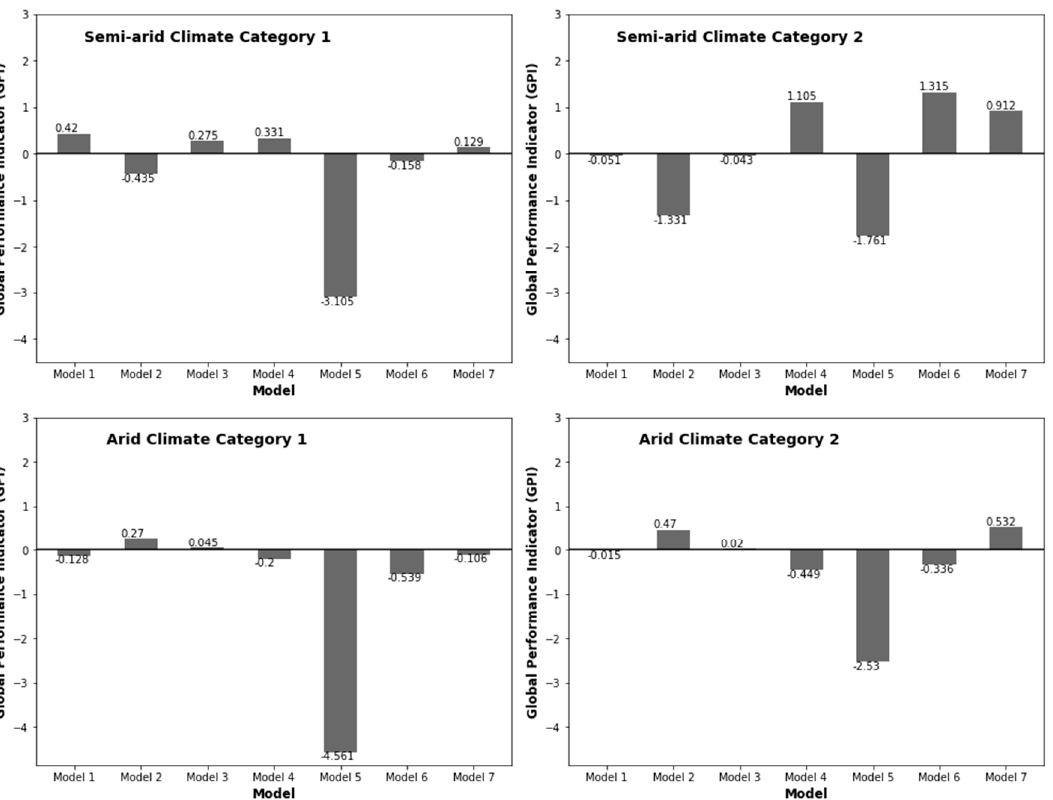
Figure 13. Global performance indicator of machine learning models at the five climatic zones of India from both categories.